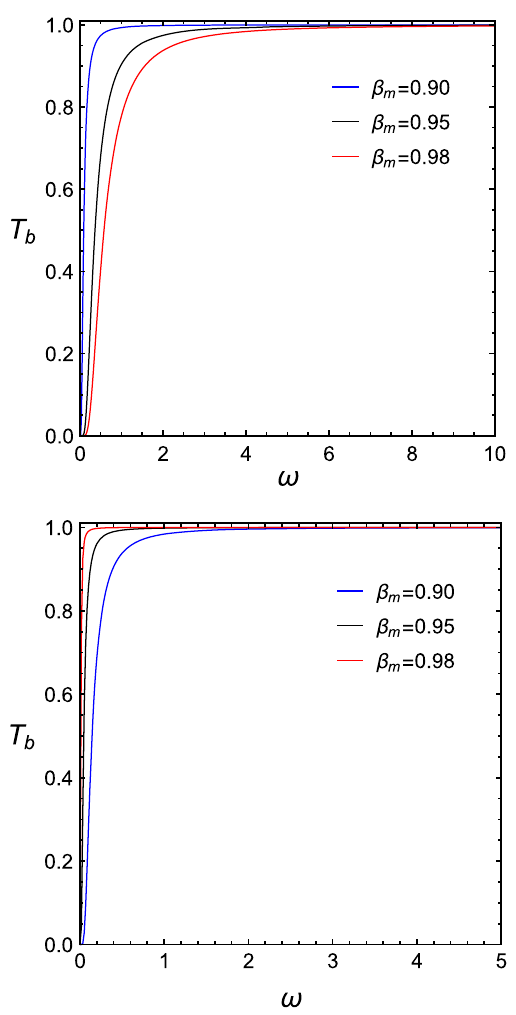
c 2 = 1. The left panel is for the one between the first and the second horizon, and the right panel is for one between the second and the third